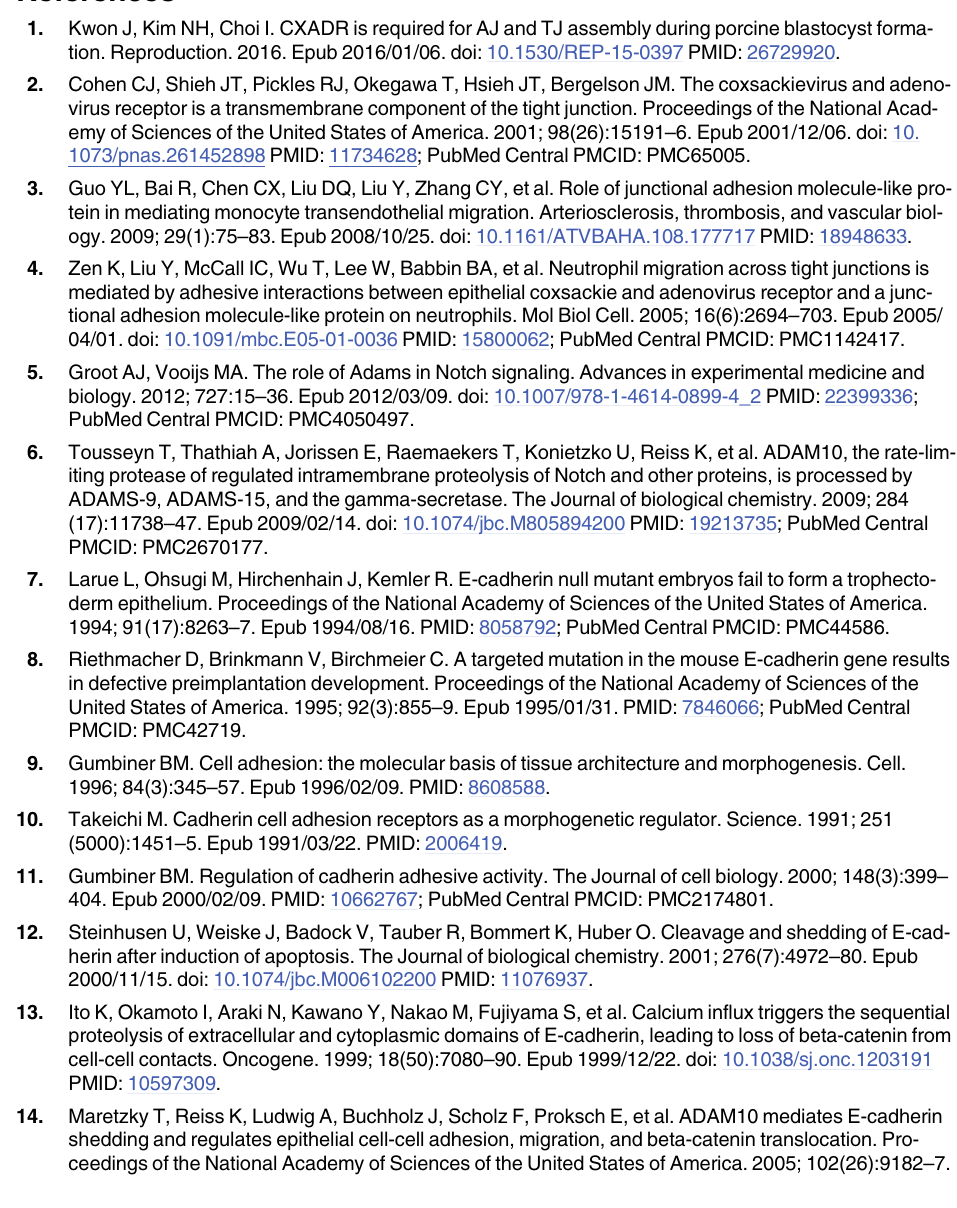
S1 Table. Primer sequences for dsRNA and qRT-PCR. dsRNA: ADAM10 dsRNA for knock- down primer. qRT-PCR: mRNA expression check